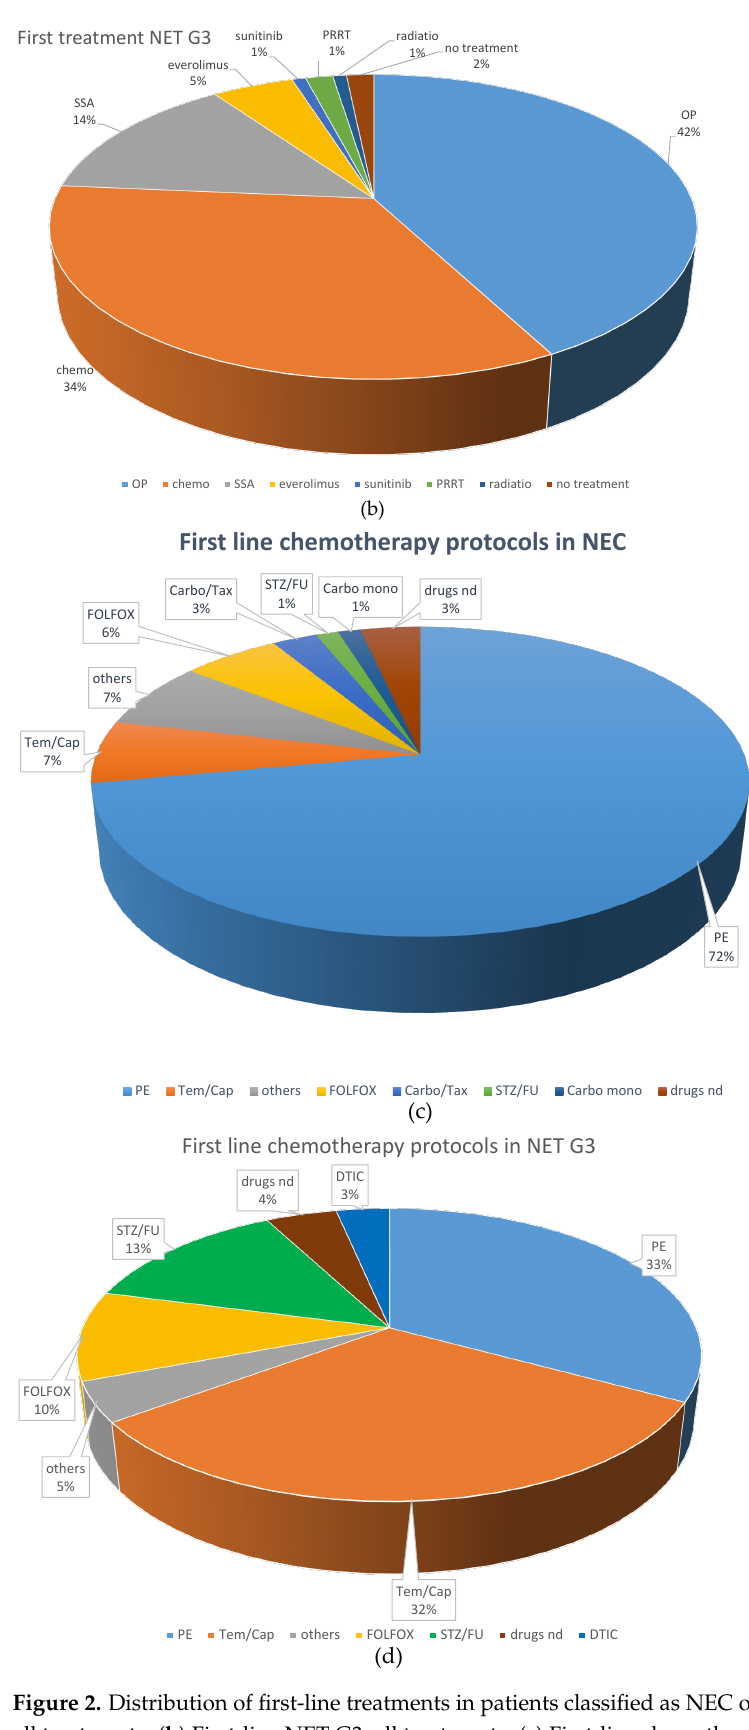
Figure 2. Distribution of first-line treatments in patients classified as NEC or NET. ( a ) First-line NEC, all treatments. ( b ) First-line NET G3, all treatments. ( c ) First-line chemotherapeutic protocols in